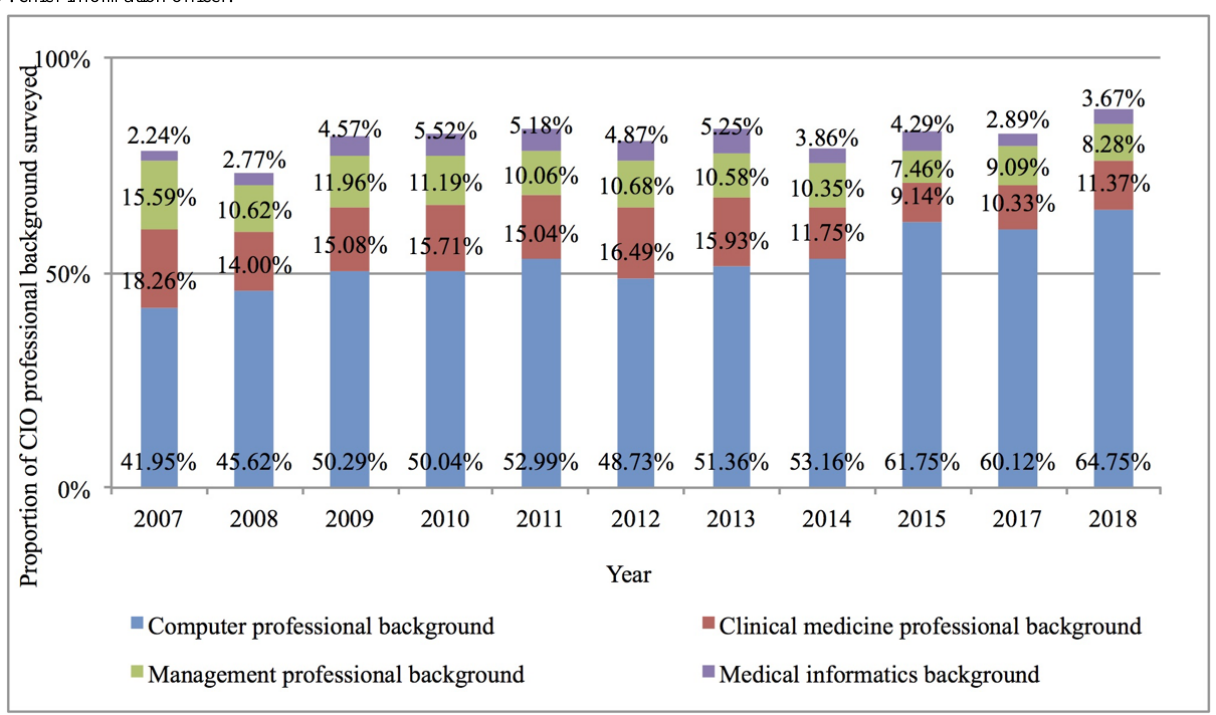
Figure 6. Academic background and composition of chief information officers in China’s hospital information technology centers from 2007 to 2018. CIO: chief information